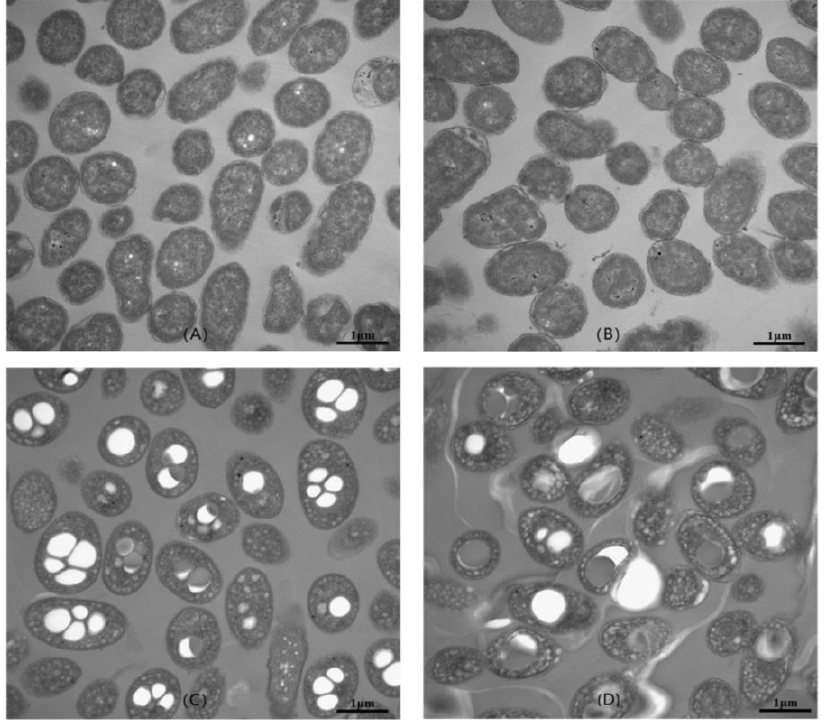
Figure 4. TEM micrographs of V. alginolyticus LHF01 ( A , C ) and LHF02 ( B , D ). Strains were cultivated in TYS medium ( A , B ) or TYS medium supplemented with 20 g/L glycerol ( C , D ) at 37 ◦ C and 200 rpm for 24 h. Table 2. Molecular weight of PHB produced by V. alginolyticus LHF01 and LHF02.